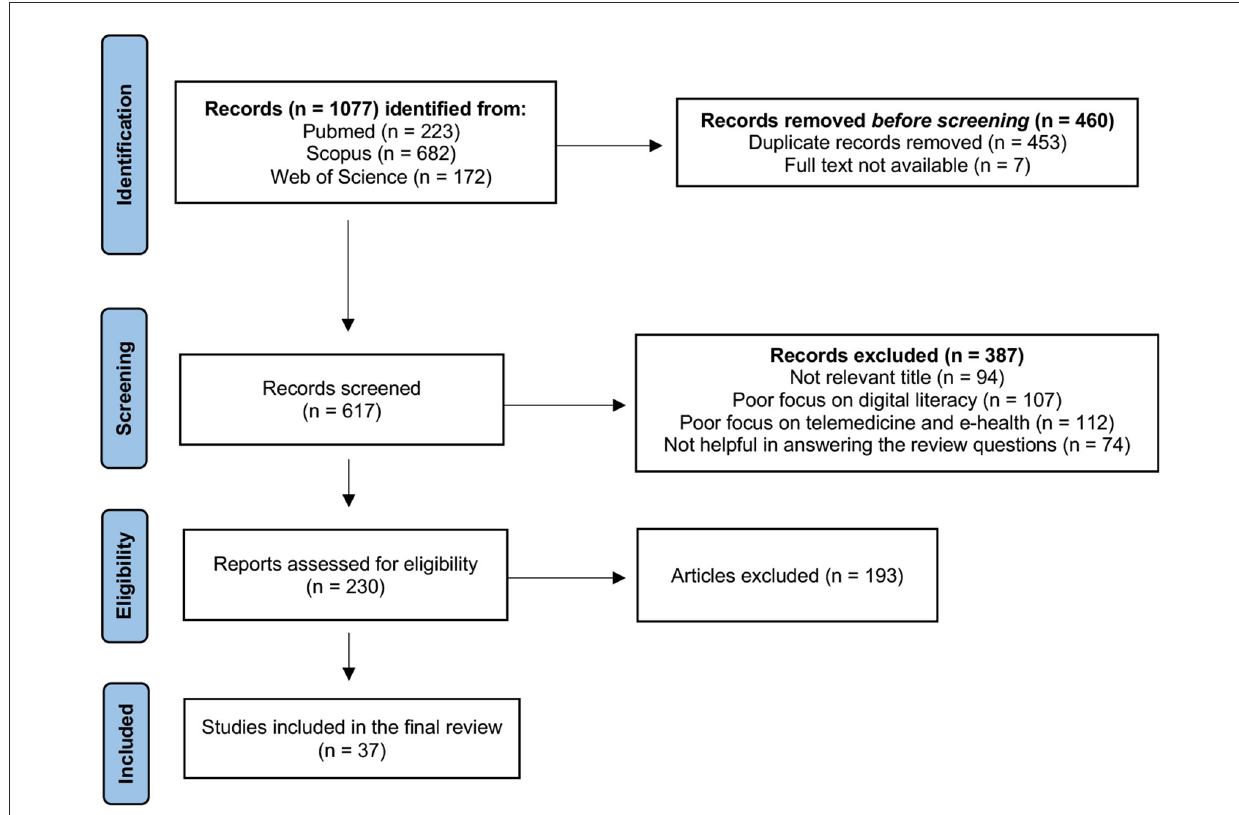
FIGURE1 Article selection